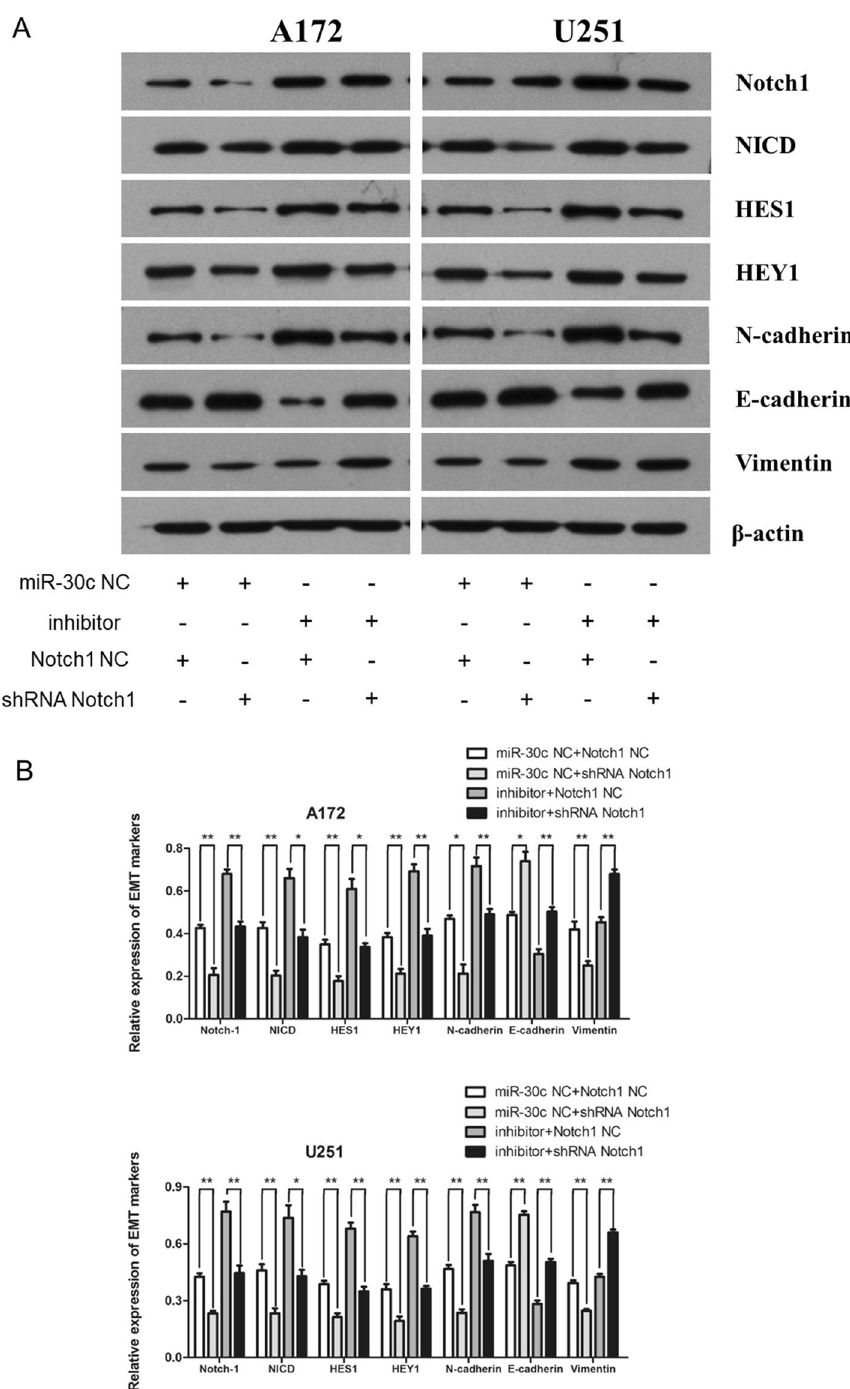
Figure 8. The miR-30c-mediated EMT depended on Notch1. ( A , B ) shRNA-Notch1 attenuated the effect of the miR-30c inhibitor on the Notch1, NICD, HES1 and HEY1 proteins of A172 and U251 glioma cells. The miR-30c inhibitor triggered an increase in N-cadherin and a decrease in E-cadherin, while cotransfection with shRNA- Notch1 partially eliminated these effects. However, the expression of Vimentin was not affected (* P < 0.05, ** P <